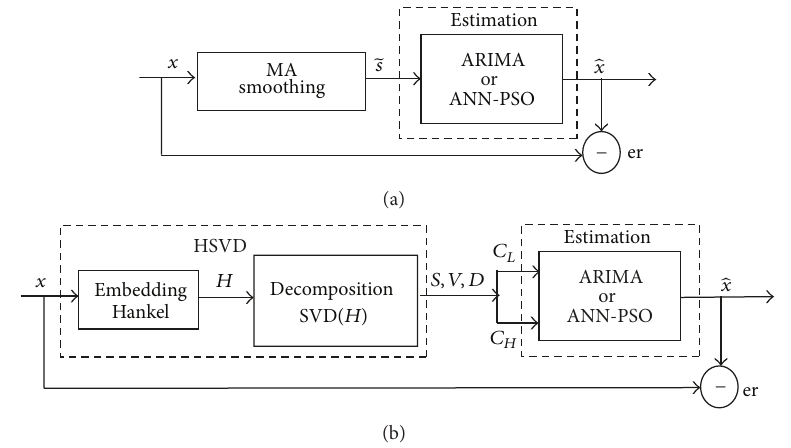
Figure 1: Smoothing strategies: (a) moving average and (b) Hankel singular value